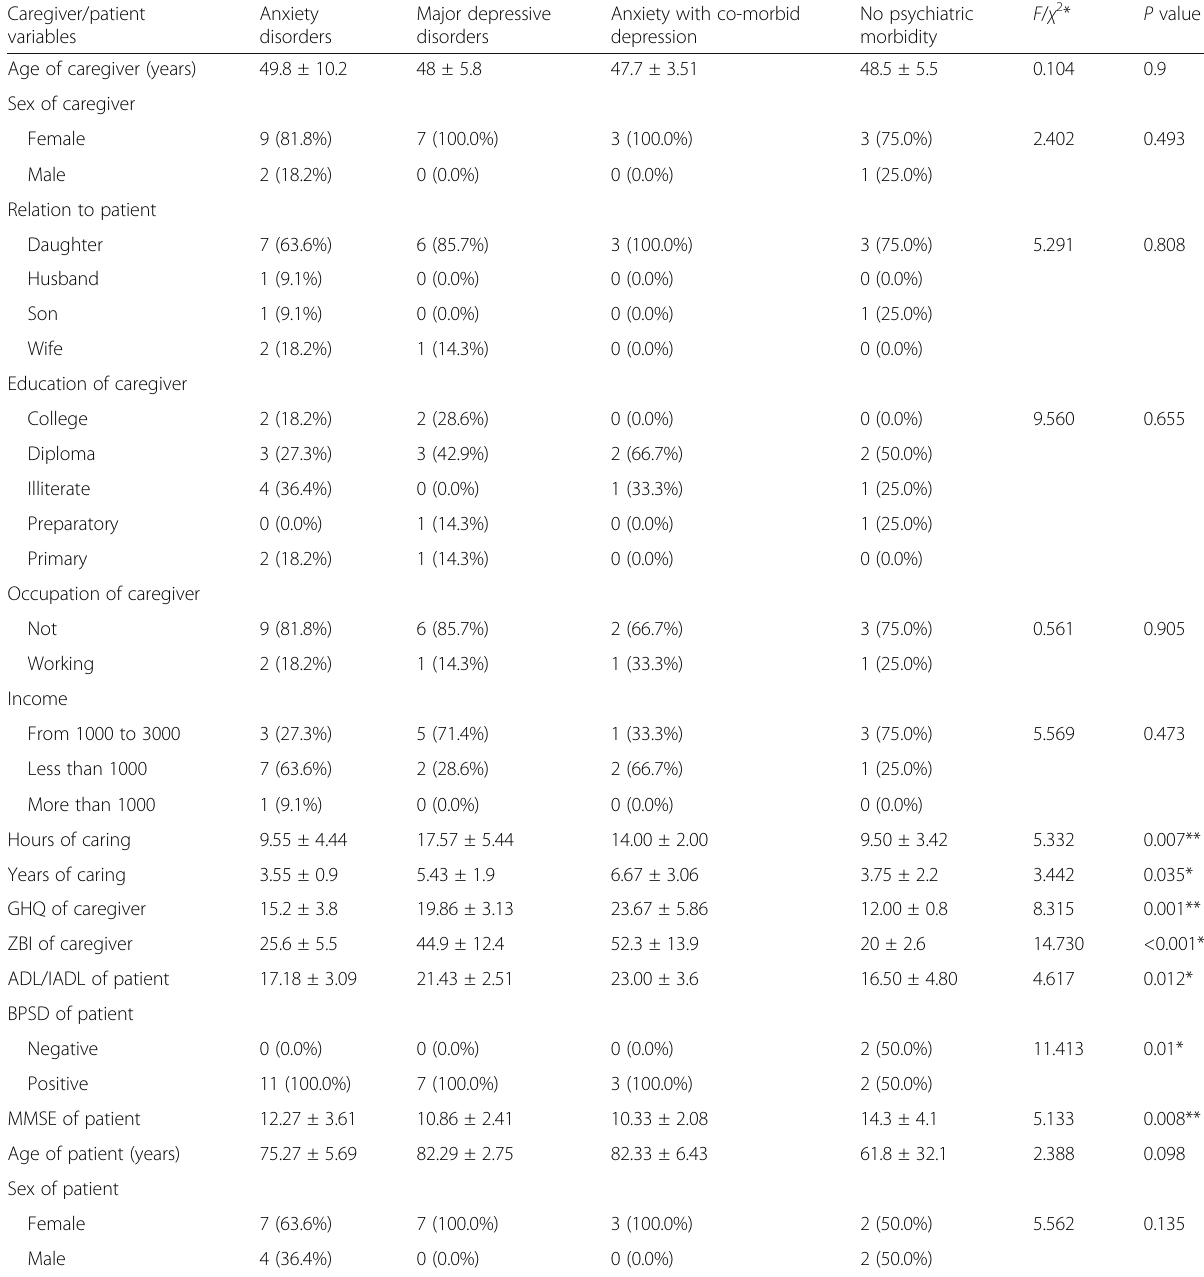
Table 4 Association between psychiatric morbidity in dementia caregivers and their sociodemographic and clinical variables Caregiver/patient variables